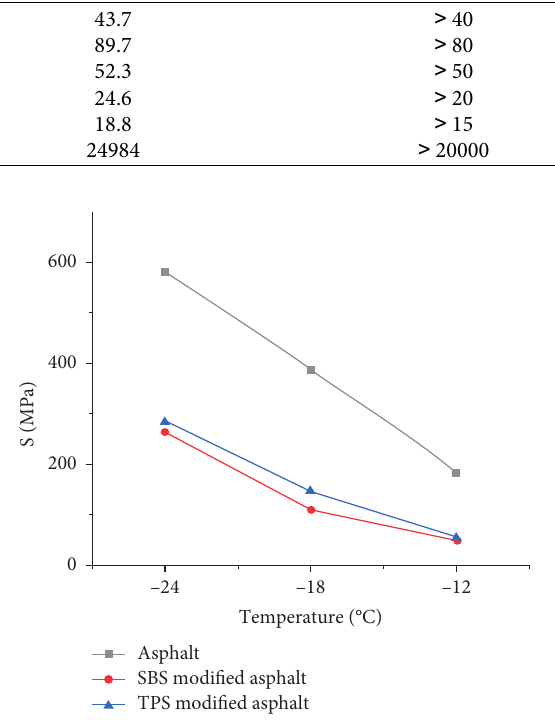
Figure 11: Stiffness modulus-temperature diagram.